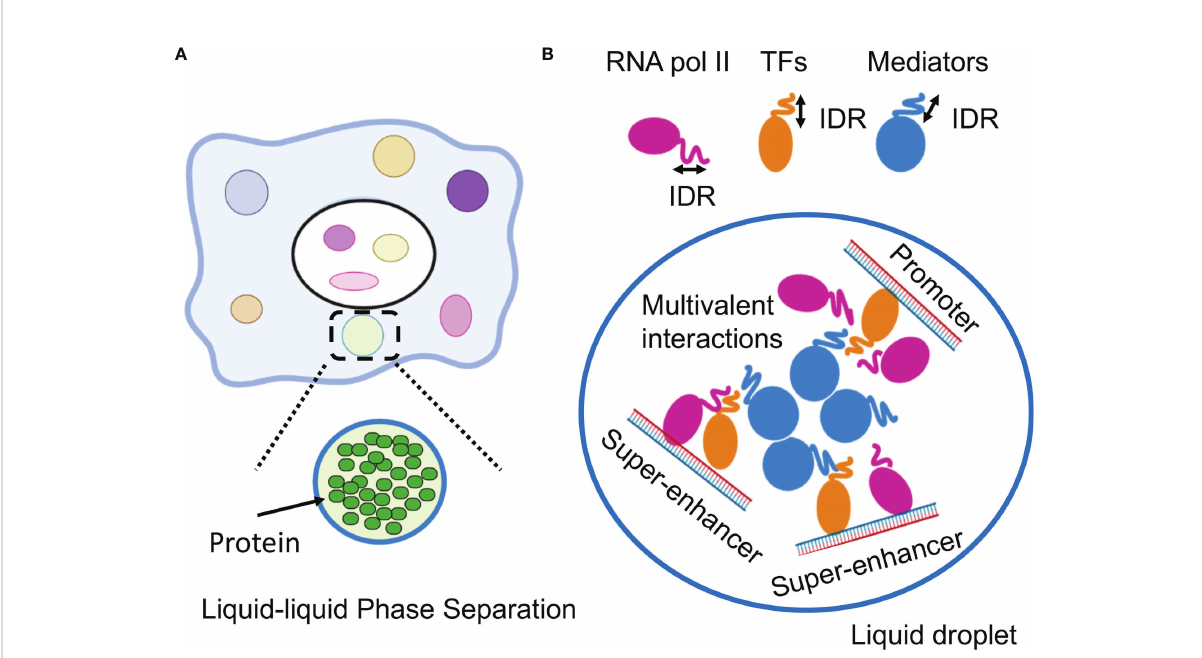
FIGURE 2 Phase-separation by transcription factors and epigenetic factors. (A) Schematic representation of the molecular system that can form the liquid- liquid phase-separation (LLPS). (B) LLPS formation by multimolecular complex of transcriptional regulators at super-enhancers for activating gene expression. IDR, intrinsically disordered